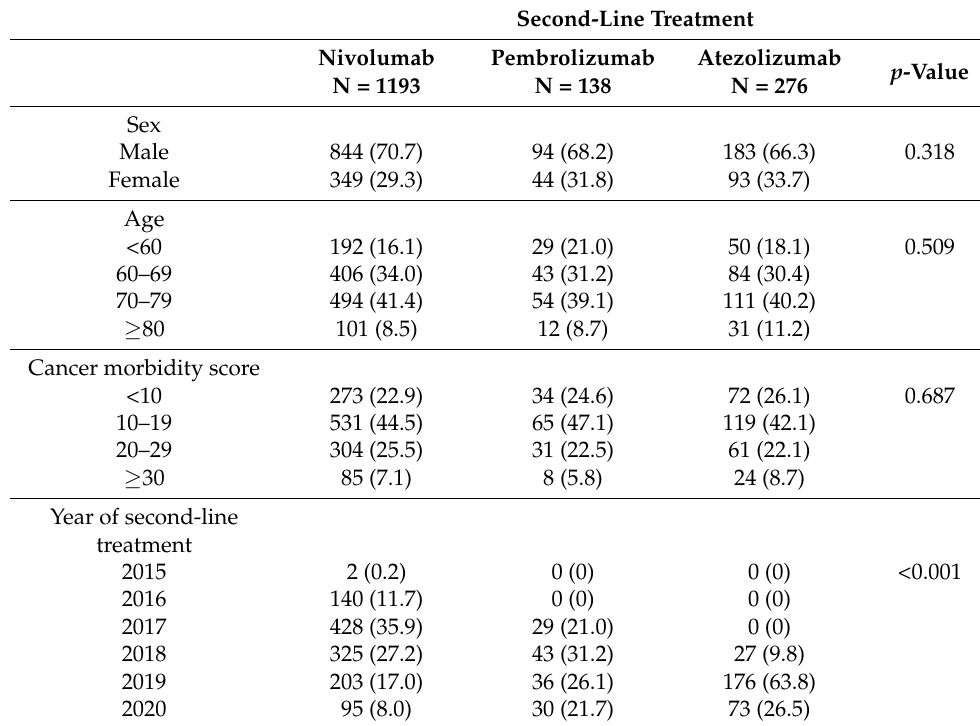
Table 1. Characteristics of 1607 advanced NSCLC patients starting a second-line treatment with nivolumab, pembrolizumab and